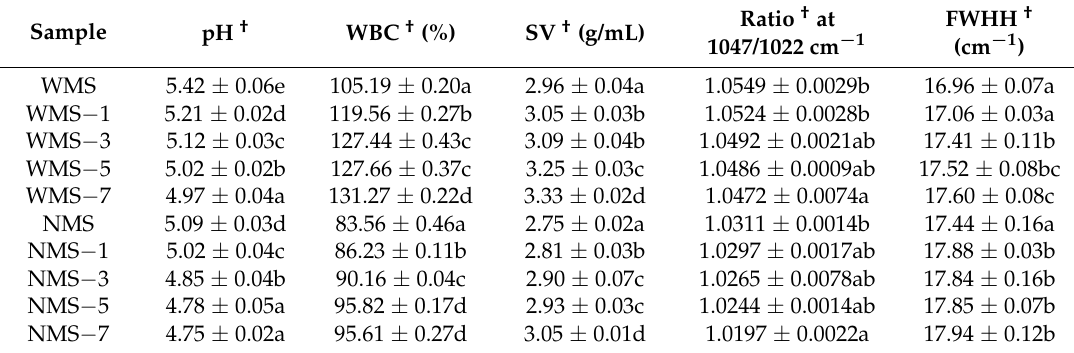
Table 1. Structure and physicochemical properties of untreated and APPJ-treated starch